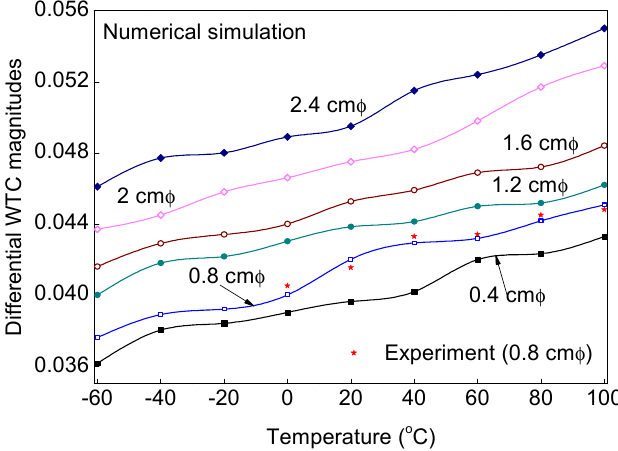
Figure 13. Change in WT-coefficient magnitudes between the bonded and debond (with different sizes) influenced signals under variable temperature conditions.